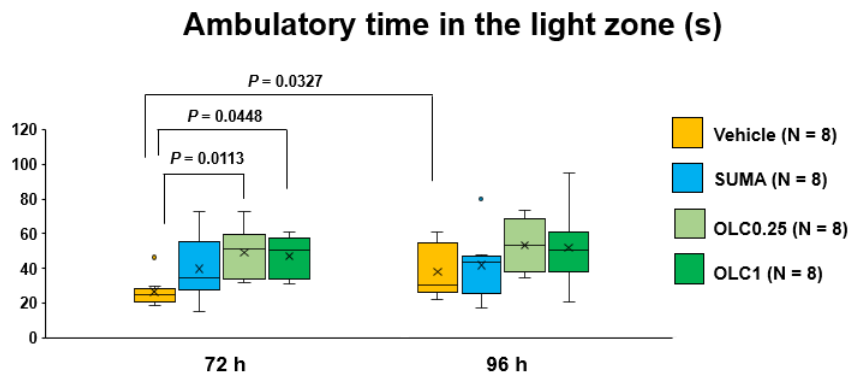
Figure 4. Ambulatory time in the light zone in each group. Data are plotted in the box-and-whisker box. The ordinate represents the sum of ambulatory time spent in the light zone during the evaluation period. Statistical analysis was performed using the two-way repeated measures ANOVA with effective matching to evaluate the effects of time and pharmacological interventions. Multiple comparisons were made by Sidak’s test for identical groups between 72 h and 96 h and by Dunnett’s test for different groups at the same timepoint. N = 8 in each group. Vehicle: Vehicle group, SUMA: Sumatriptan group, OLC0.25: Olcegepant 0.25 mg group, OLC1: Olcegepant 1 mg group.